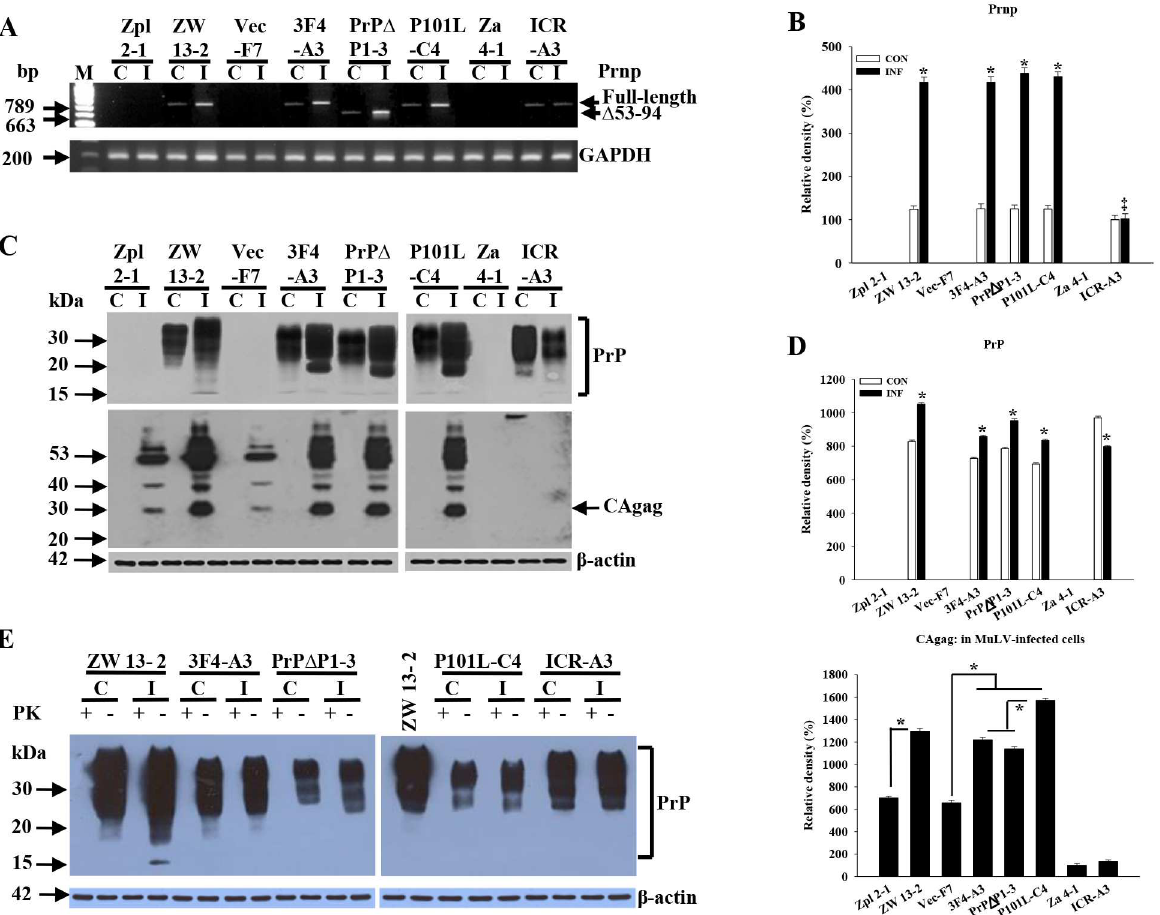
Fig 5. Correlation of PrP C and MuLV infection in neuronal and astroglial cells. (A) Prnp expressionlevels in Prnp +/+ neuronaland glial cells. Prnp +/+ neuronalcells showed up-regulation after MuLV infection. Prnp +/+ astroglialcells showedno statisticallysignificant differences from uninfectedcells. (B) Densitometry analysisof Prnp expressionshowedsignificantdifferences betweeninfected and control neuronalcells ( * p < 0.05). There was no difference in expressionof Prnp +/+ betweencontrol and infected ICR-A3. (C, D) In neuronal cells, significantcorrelationwas observedbetweenPrP C expressionand MuLV antigen. PrP C protein levels were up-regulated in MuLV-infected neuronal cells, but expressionwas down-regulatedin astroglialcells. PrP +/+ cells showedsignificantly higherlevels of CAgagthan PrP -/- cells ( * p < 0.01). Cells expressingP101L mutant form showedsignificantly higherlevels of CAgagthan wild-typeand octarepeat deletionforms of PrP C ( * p < 0.05). Astroglial cells showedsignificantly lower levels of MuLV infectionthan either PrP -/- or PrP +/+ neuronalcells († p < 0.01). (E) The biochemicalcharacter of PrP C in non-infected and MuLV-infected cells was investigatedusing PK treatment (20 μ g/mL). ExpressedPrP showedno PK-resistant form in either non-infected or MuLV-infected neuronaland astroglial